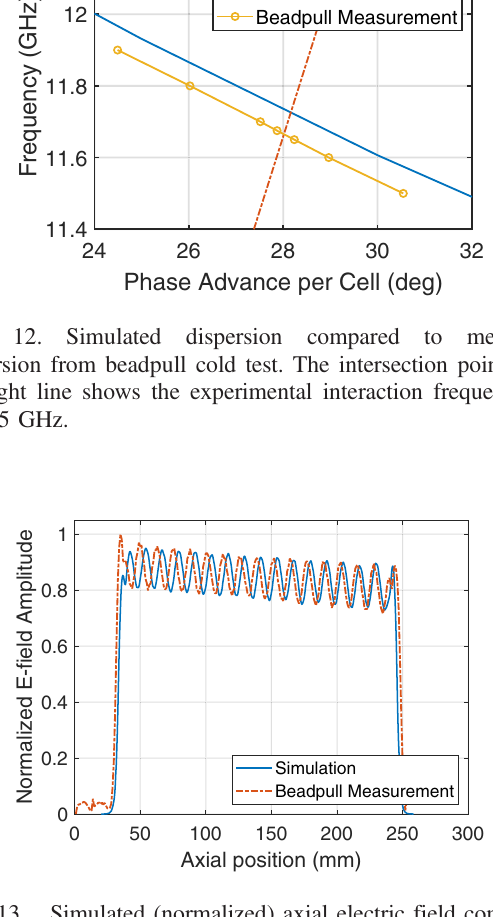
FIG. 13. Simulated (normalized) axial electric field compared to measured values from beadpull experiment at 11.675